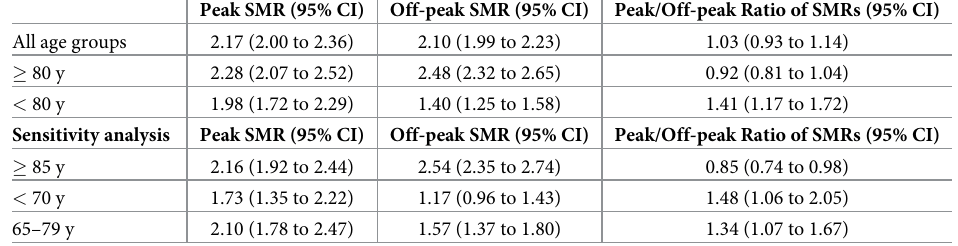
Table 3. Standardized mortality according to age during peak and off-peak phases of the COVID-19 epidemic in Milan.